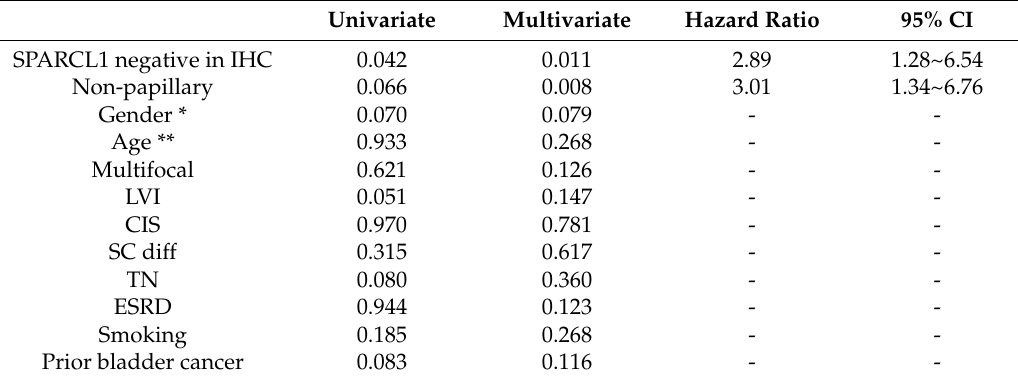
Table 2. Regression analysis for systemic UTUC